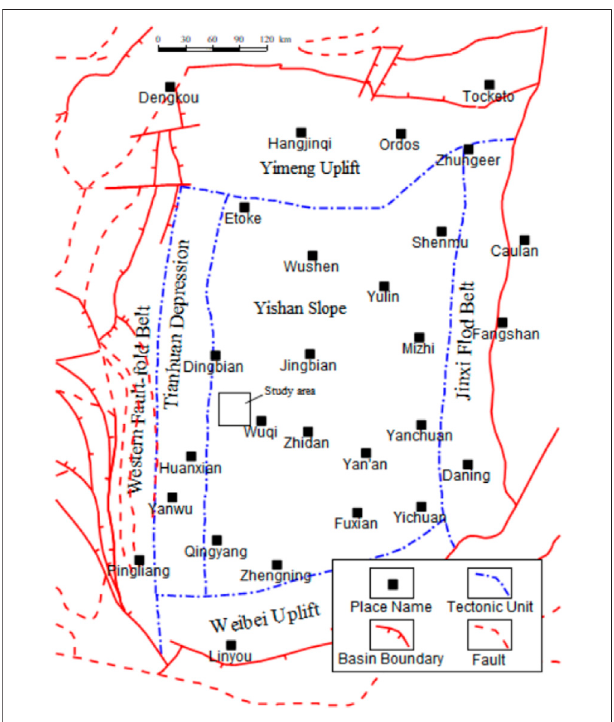
FIGURE1| ThestudyareaislocatedinthewestpartoftheYishanSlope in the Ordos